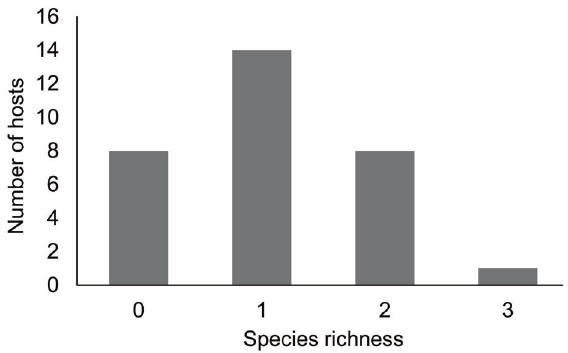
Figure 2 - Species richness of metazoan parasites in Hemibrycon surinamensis from the Matapi River, in Amapá State, Brazil.